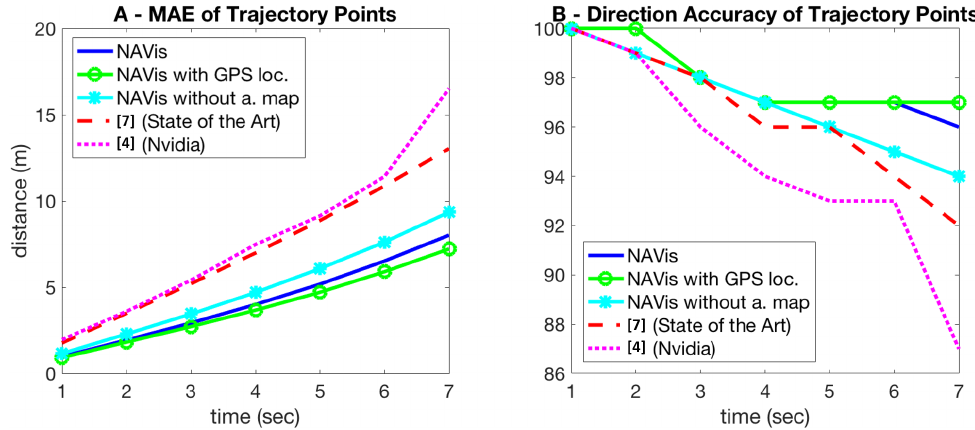
Figure 6. ( A ) Mean average error in seconds (sec) of time-trajectories points (lower is better). ( B ) the accuracy of direction in intersections for trajectory points (higher is better). The percentage of positions predicted on the correct route, is mostly higher for our models.